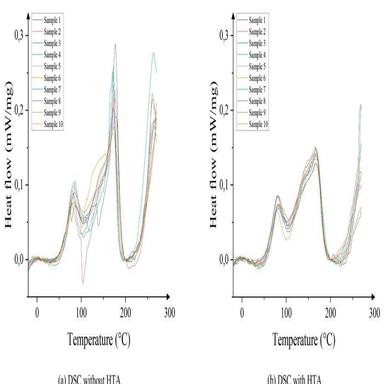
DSC results of TPU measurements considering a heating rate of 30 ◦C/min: DSC measurements (a) without and (b) with Kryonaut.